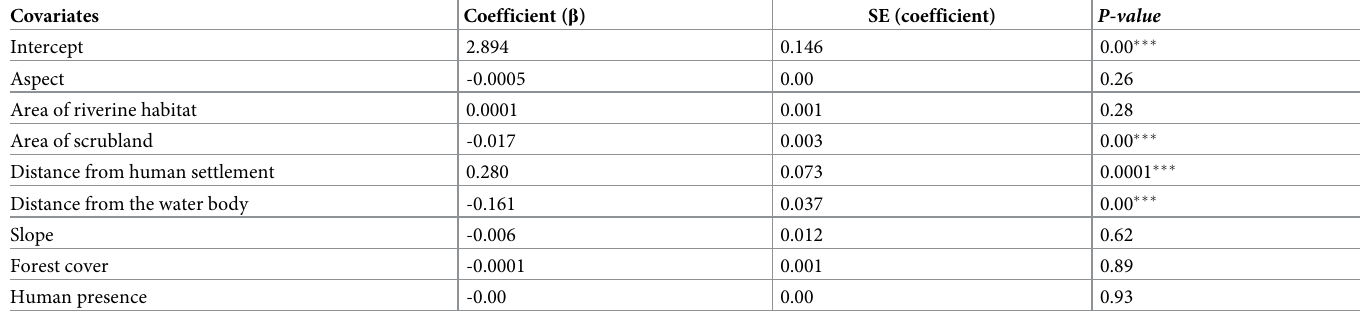
Table 3. GLM model average coefficient ( β ) with standard error values (SE) of the variables to explain the site use by striped hyena in the sampling area. � = statisti- cally significant at P � 0.05.